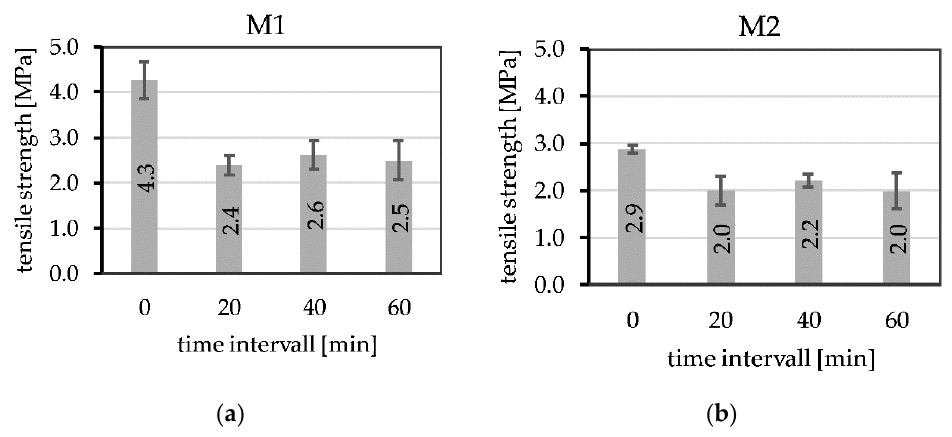
Figure 16. Results of the lateral tensile tests on the TRM depending on the rest time between the mortar layers (time interval). (Mean values of five single values, with standard deviation indicated) ( a ) M1—T 1C; ( b ) M2—T 1C.